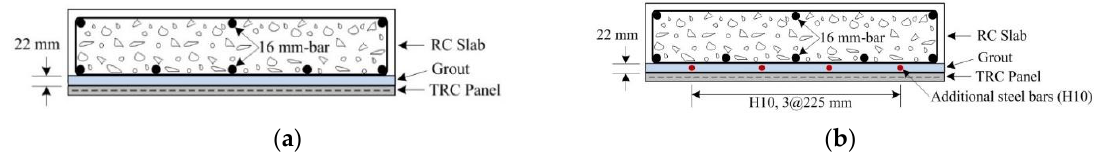
Figure 5. TRC panel strengthening plan: ( a ) SP series; ( b ) SSP series (units: mm).